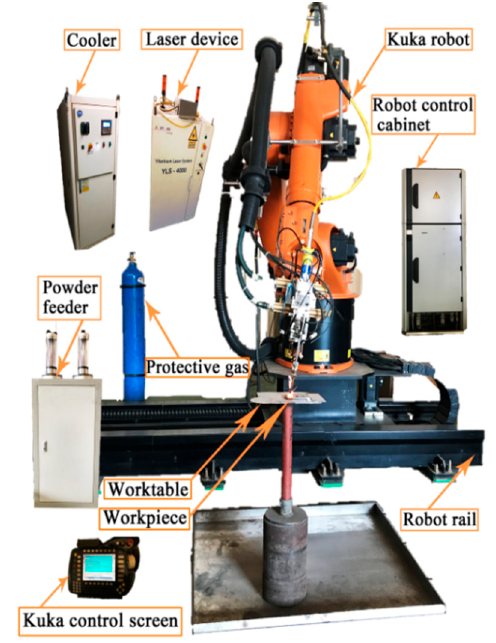
Figure 1. Laser cladding equipment.